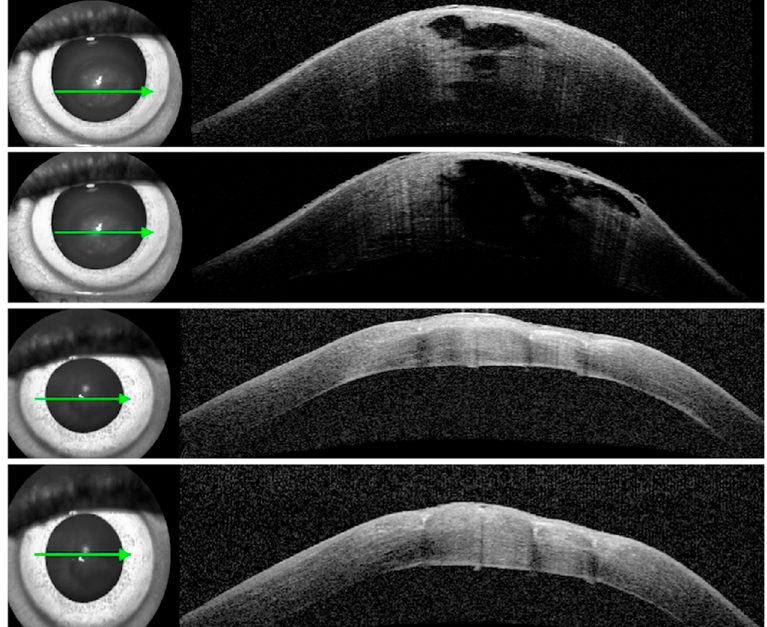
Figure 3. Anterior segment OCT: pre-op with a stromal cleft ( top 2 scans) and apex pachymetry of 1380 µ, and 8 days post-op ( bottom 2 scans) with apex pachymetry of 548 µ. The arrow shows the level of the scan.